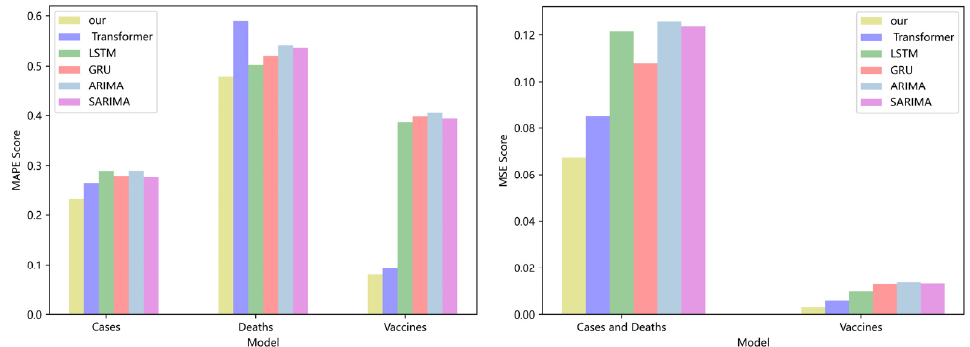
Figure 5. Comparison of MAPE and MSE score for VA cases, deaths, and vaccines.